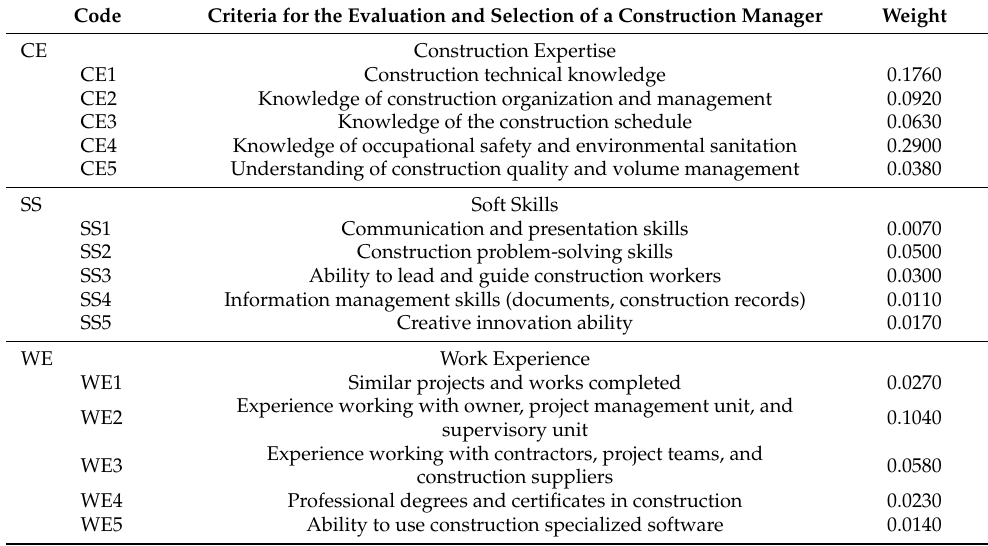
Table 2. The weight of criteria for the evaluation and selection of a construction manager.